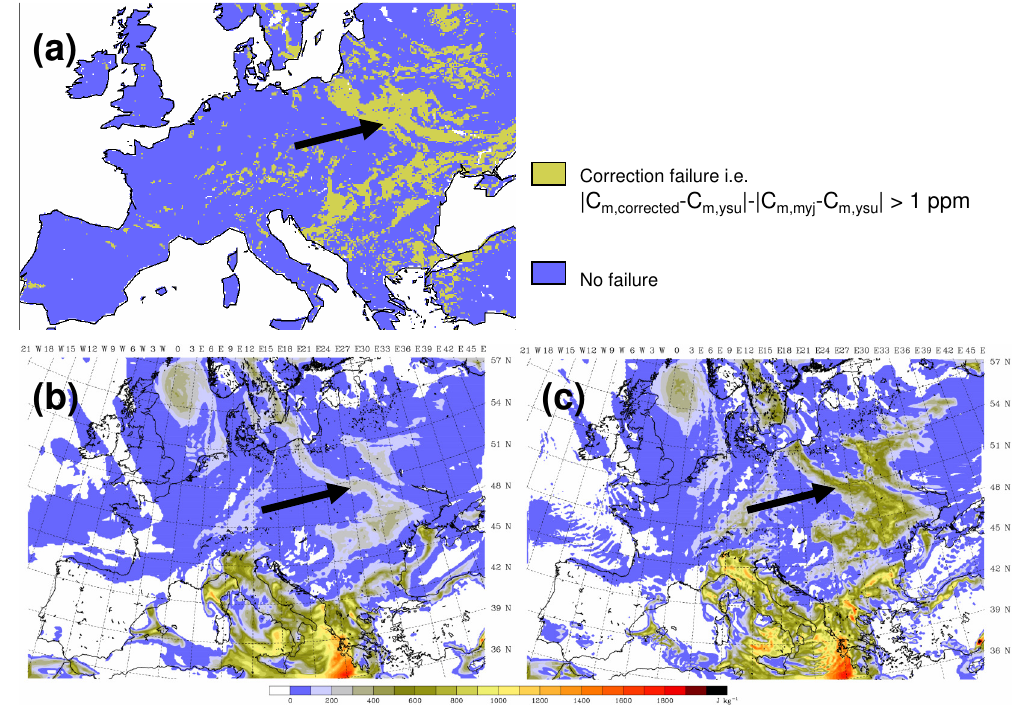
Fig. 13. Grid cells for which the reshuffling method failed calculated for 10 August 2006, 12:00UTC (a) . Also shown is the Convective Available Potential Energy (CAPE) for YSU (b) and MYJ (c) at the same time. Details are given in the Grid cells for which the reshuffling method failed calculated for August 10, 2006, 12:00 UTC a). Also shown is the Convective Available Potential Energy (CAPE) for YSU b) and MYJ c) at the same time. Details are given in the text.